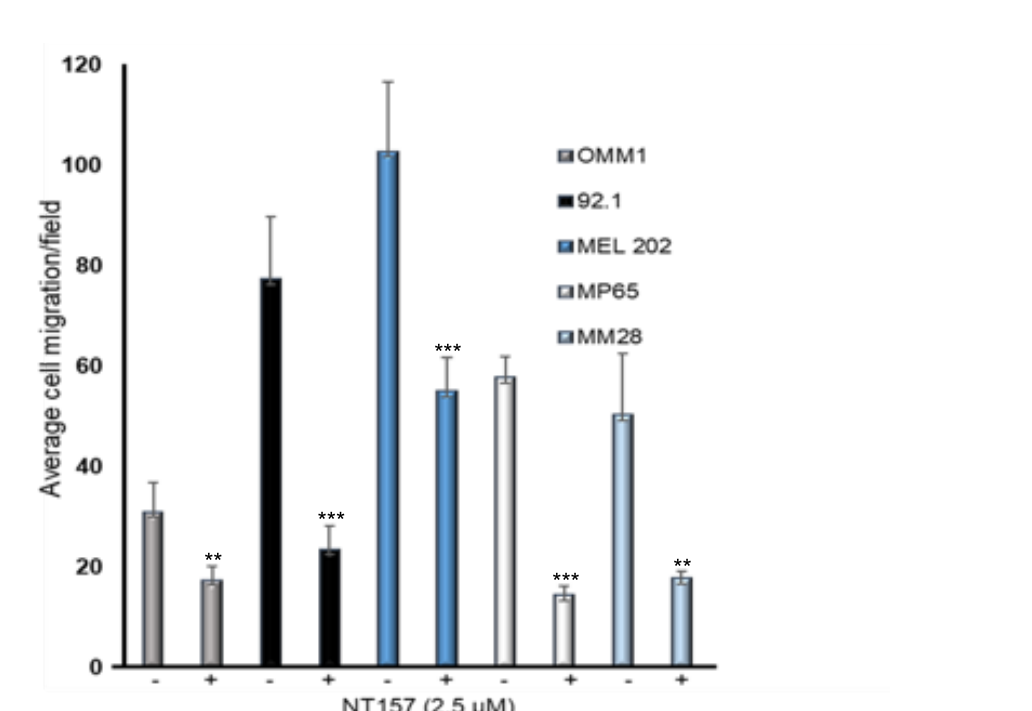
Figure 2. NT157 treatment reduces IRS-1 levels leading to a reduction of cell viability, migration, and induction of apoptosis in UM cell lines. ( A ) TCGA database analysis shows high expression of IRS-1 mRNA in UM tumors (indicated by an arrow) among 33 cancer (red dots) and corresponding normal (green dots) tissues. ( B ) Immunohistochemical staining of matched primary (eye) and metastatic (liver) UM tumor tissues using IRS-1 antibody detects IRS-1 expression (purple) in both eye and liver (both 2 × and 20 × magnifications are shown). ( C ) Western blot analysis of cell extracts from UM cell lines (92.1, OMM2.5, OMM1, MEL20-06-039, MP65) treated with NT157 (1 µ M) and probed with anti-IRS-1 antibody shows IRS-1 protein levels decrease in UM cell lines with NT157 treatment for 48 h. ( D ) Quantification of percent cell survival using MTT-based assays in UM cell lines (MP46, MM28, MEL202, 92.1, MP65, and MP41) with (0.05, 0.1, 0.25, 0.5, 1.0, 2.5 µ M) or without NT157 treatment (72 h) shows NT157 dose-dependent decrease in cell survival. The bar graphs represent a percentage of cell survival and are a mean ± SD of three independent experiments. p-values were calculated by comparing untreated controls with NT157 treatment doses ( * p < 0.05; ** p < 0.01; *** p < 0.001). ( E ) Colony formation assay: Representative images of crystal violet staining shows fewer colonies formed by UM cell lines (MP46, MM28, MEL202, 92.1, MP65, and MP41) with NT157 treatment (1 and 2.5 µ M for seven days) compared to untreated controls. ( F ) Representative FACS histograms of DNA content detected by propidium iodide staining to detect cell cycle status in UM cell lines (MP46, MM28 and MEL20-06-039, and MP65) show a dose-dependent increase in the number of cells in G0/G1 phase with NT157 treatment (1 and 2.5 µ M for 72 h) vs. no treatment. ( G ) Western blot analysis of total cell extracts shows NT157 dose-dependent (1 and 2.5 µ M for 72 h) increase in cleaved PARP and decrease in caspase 3 levels detected by respective antibodies in UM cell lines (MEL202, MEL270, 92.1, and MEL20-06-039) compared to untreated controls. ( H ) Quantification of cell migration in UM cell lines (OMM1, 92.1, MEL202, MP65, and MM28) shows a reduction in migration of cells treated with NT157 (2.5 µ M) compared to untreated controls. An average of five fields of cells/filter were counted under a microscope with 40 × magnification. The average number of cells counted/field were obtained in two independent experiments and the mean ± SD of these average cell counts/field were plotted as bar graphs. p -values were calculated by comparing untreated vs. NT157 treated cells ( * p < 0.05; ** p < 0.01; *** p <